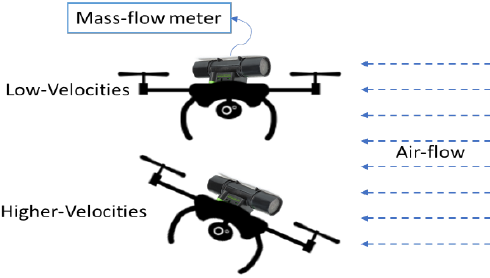
Figure 6. Quadcopter tilting (Higher velocities) and its effect on Mass-Flow meter.